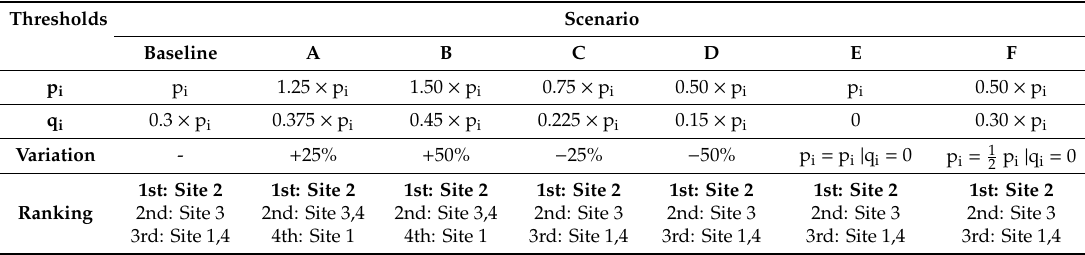
Figure 2. Optimal UABT location: ( a ) Ascending and descending distillations - ( b ) Ranking of alternative locations. Table 4. Sensitivity